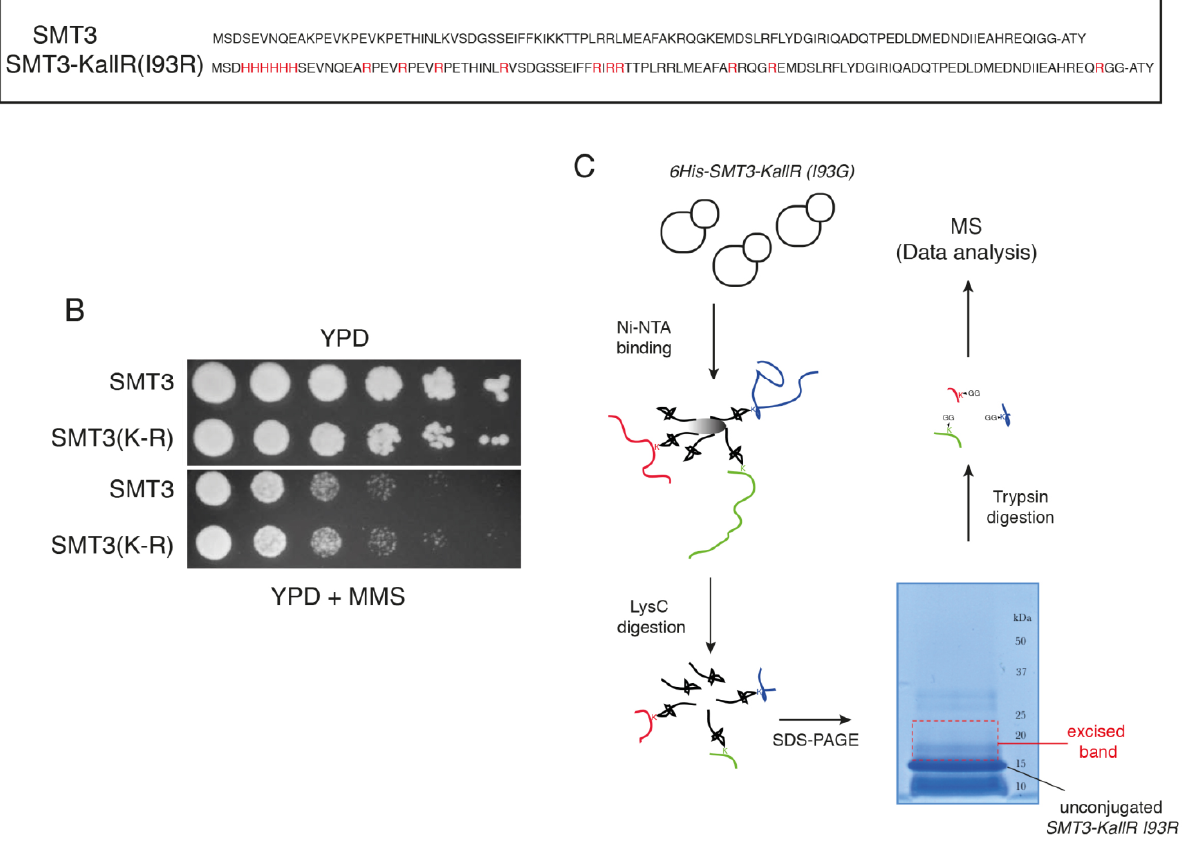
OPEN ACCESS | www.microbialcell.com 332 Microbial Cell | OCTOBER 2017 | Vol. 4 No. 10